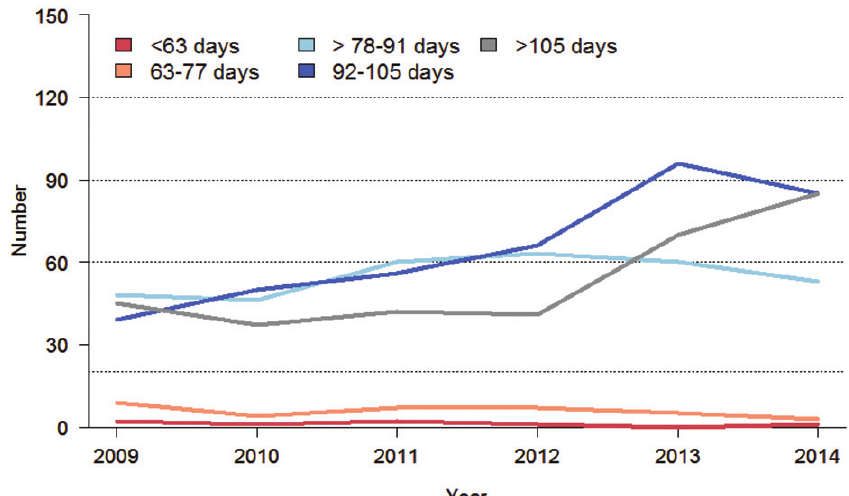
Figure 3. Time from start of chemoradiotherapy (50 – 50.4Gy in 25 – 28 fractions during 5 – 5.5 weeks with capecitabine) in Sweden 2009 – 2014. In 2009 an equal number of patients had a delay after the last radiation fraction of 6 – 8 weeks (78 – 91 days), 8 – 10 weeks (92 – 105 days), and > 10 weeks ( > 105 days). The number of patients with the longest delay was stable until 2012, after which time it increased and was more common than 8 – 10 weeks during 2014. During the entire time period, a delay of 6 – 8 weeks has been recommended. This is also recommended in the latest version from 2016 of the national care